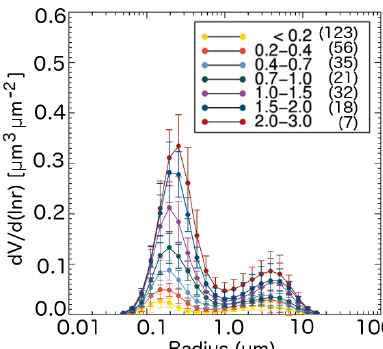
Figure 4. The real and imaginary parts of refractive index as a function of AOD at 0.675µm calculated from the AERONET inver- sion product over the five sites in Indonesia during August to Oc- tober 2015. The error bars represent the standard deviation within each wavelength. A total of 113 data points are used to generate this plot, 56 retrievals in AOD 0.4–1.0, 50 retrievals in AOD 1.0– 2.0, and 7 retrievals in AOD